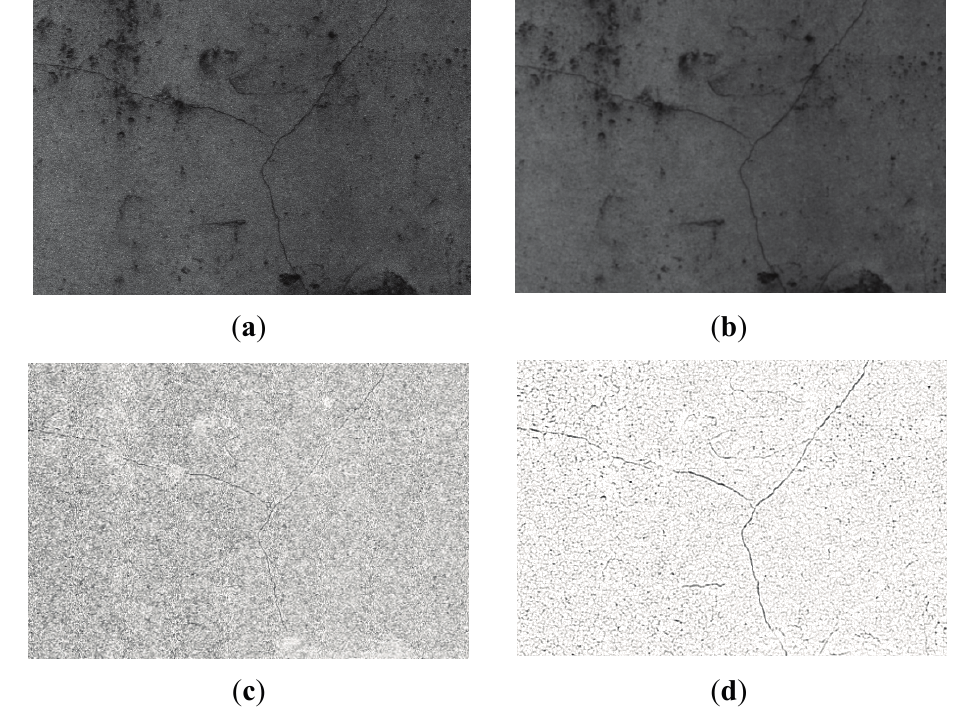
Figure 6. Examples of obtained binary sub-graphs with different parameter settings, (cid:1846) = 47 , ( a ) ( b ) (cid:1872) (cid:2868) results of Figure 5c; ( b , d , f ) are results of Figure